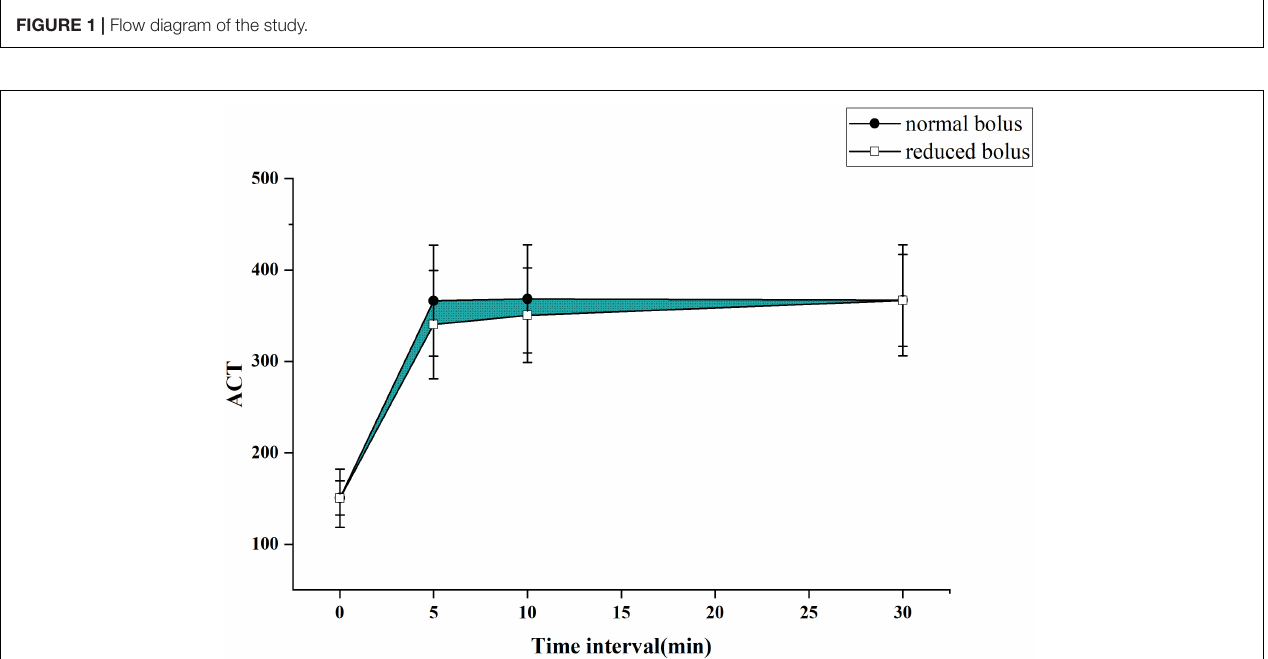
FIGURE 2 | The activated clotting time (ACT) curve in each group for patients with normal estimated glomerular filtration rate (eGFR).